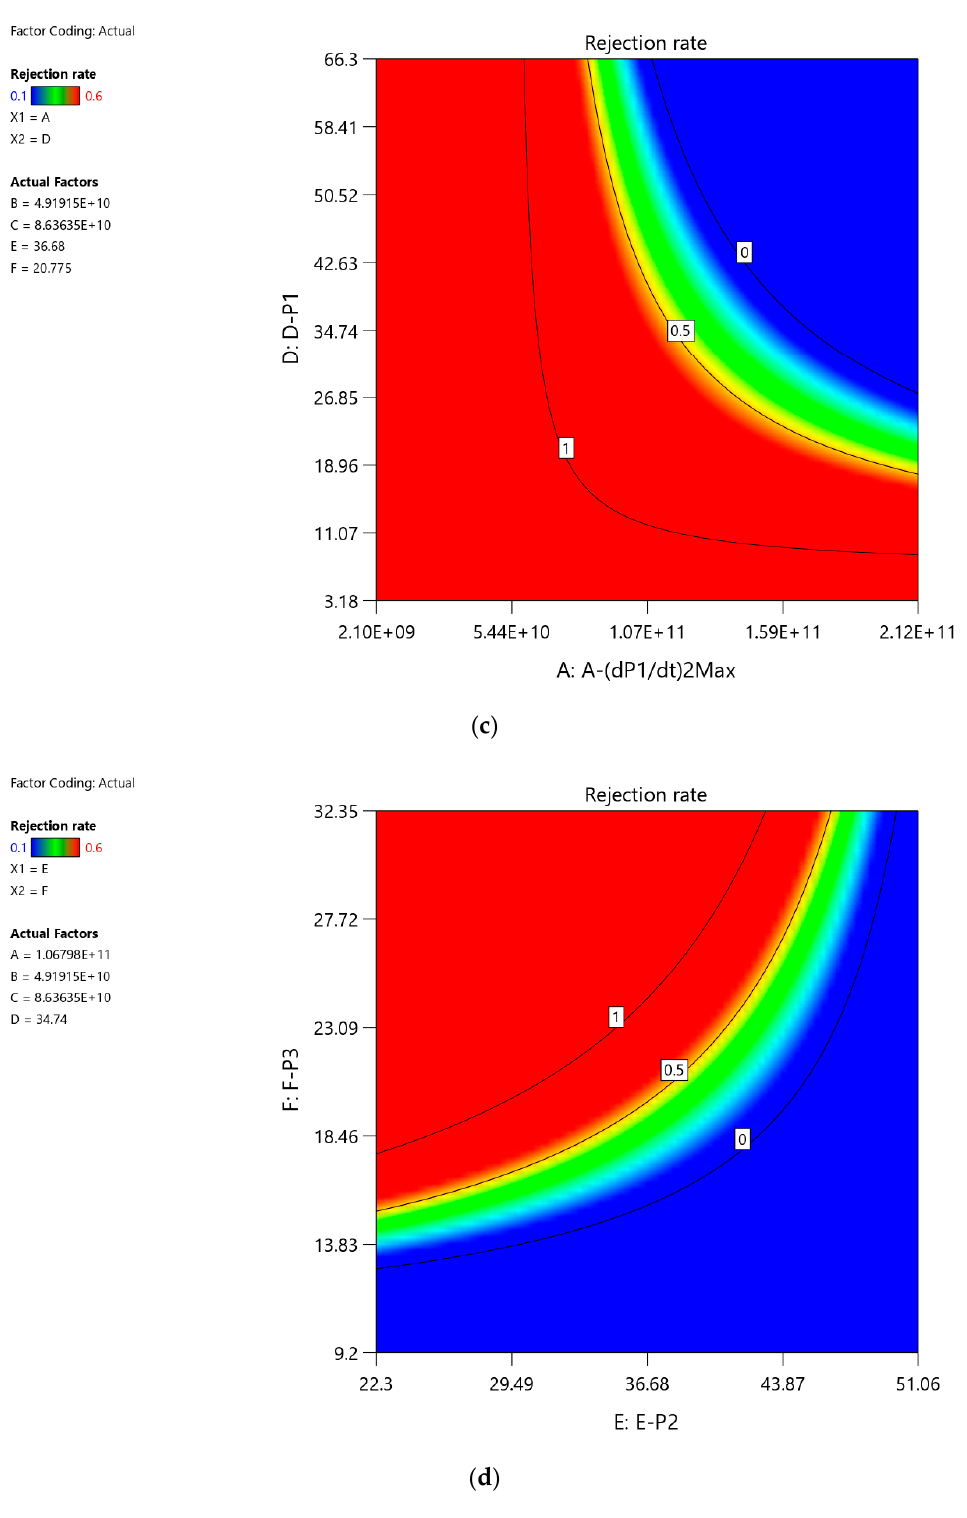
Figure 4. Discovered relationships between the process parameters and the resulting rejection rate (Blue is all pass and Red is all rejection. ( a ) Rejection rate and the A—(dP1/dt) 2Max , B—(dP2/dt) 2Max , relationship, ( b ) Rejection rate and the A—(dP1/dt) 2Max , C—(dP3/dt) 2Max relationship, ( c ) Rejection rate and the A—(dP1/dt) 2Max , D—P 1 relationship and ( d ) Rejection rate and E—P 2 , F—P 3 relationship.